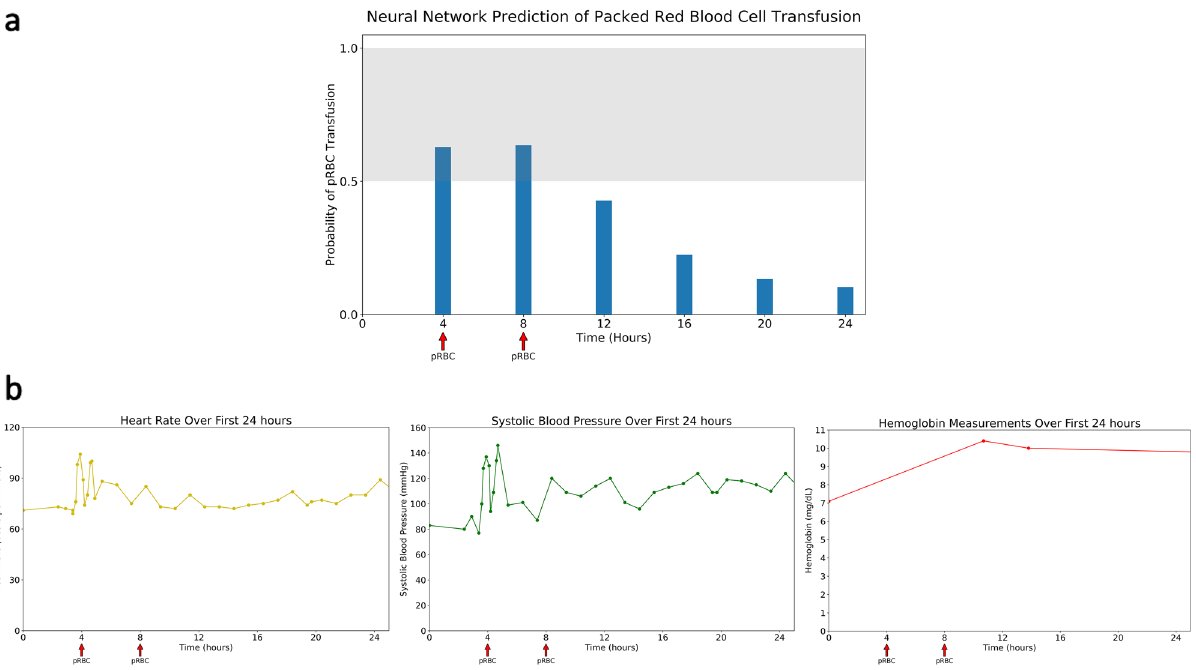
Figure 1. Example of neural network prediction for the first 24 h of a 62 year old man with Hepatitis C cirrhosis presenting with 2 days of intermittent coffee ground emesis and lethargy. Initial Glasgow Blatchford Score = 14 ( a ) Continuous risk prediction of the neural network through the first 24 h with the threshold set above 0.5 for detecting need for transfusion. The arrows indicate need for transfusion during that time period. ( b ) Measurements of Heart Rate, Systolic Blood Pressure, and Hemoglobin occurring during the first 24